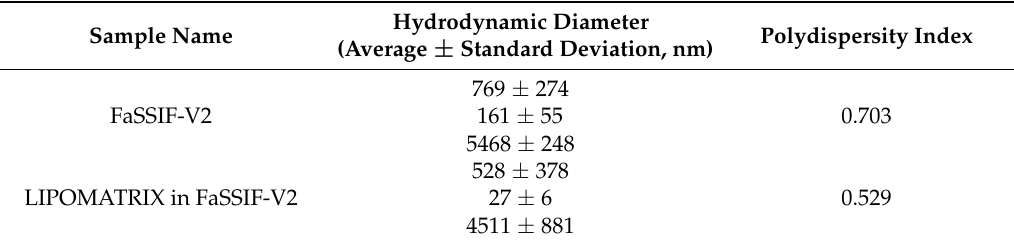
Figure 6. Particle size distribution of FaSSIF-V2 (black Line) and LIPOMATRIX in FaSSIF-V2 (red line) after sonication ( n = 5). Table 2. Principal parameters of particle size distribution of the LIPOMATRIX in FaSSIF-V2 sample after sonication.